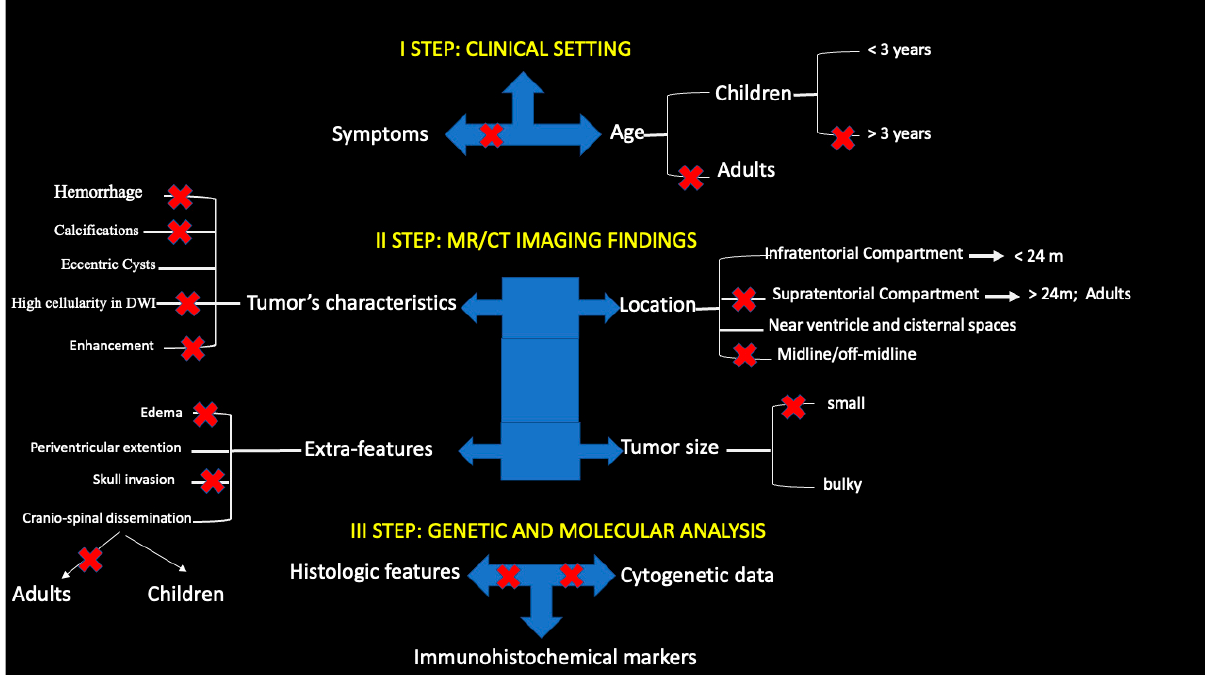
Figure 5. A flowchart of clinical and imaging findings in ATRT . A three-step route shows distinctive features of ATRT able to guide the ATRT diagnosis. X indicates nonspecific findings.